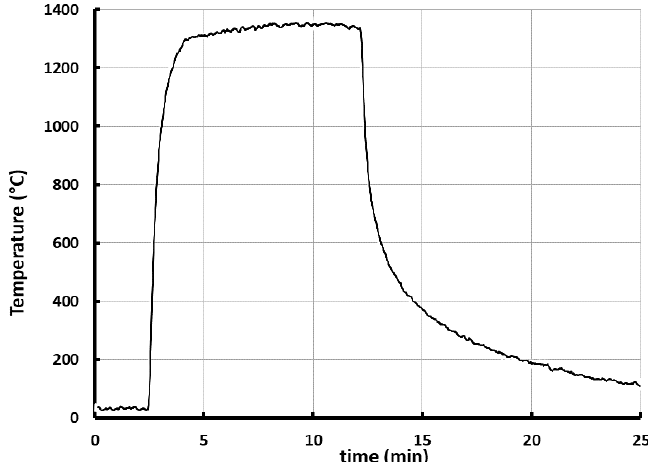
Figure 5. Inner reactor temperature vs. time for milli-scale reactor. The rapid heating rate is a function of the small reactor size.